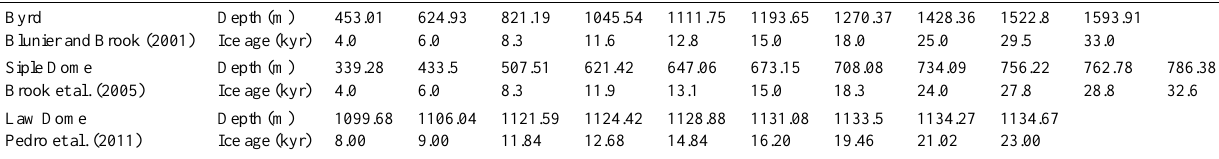
Table 4. Depth–age tie points.